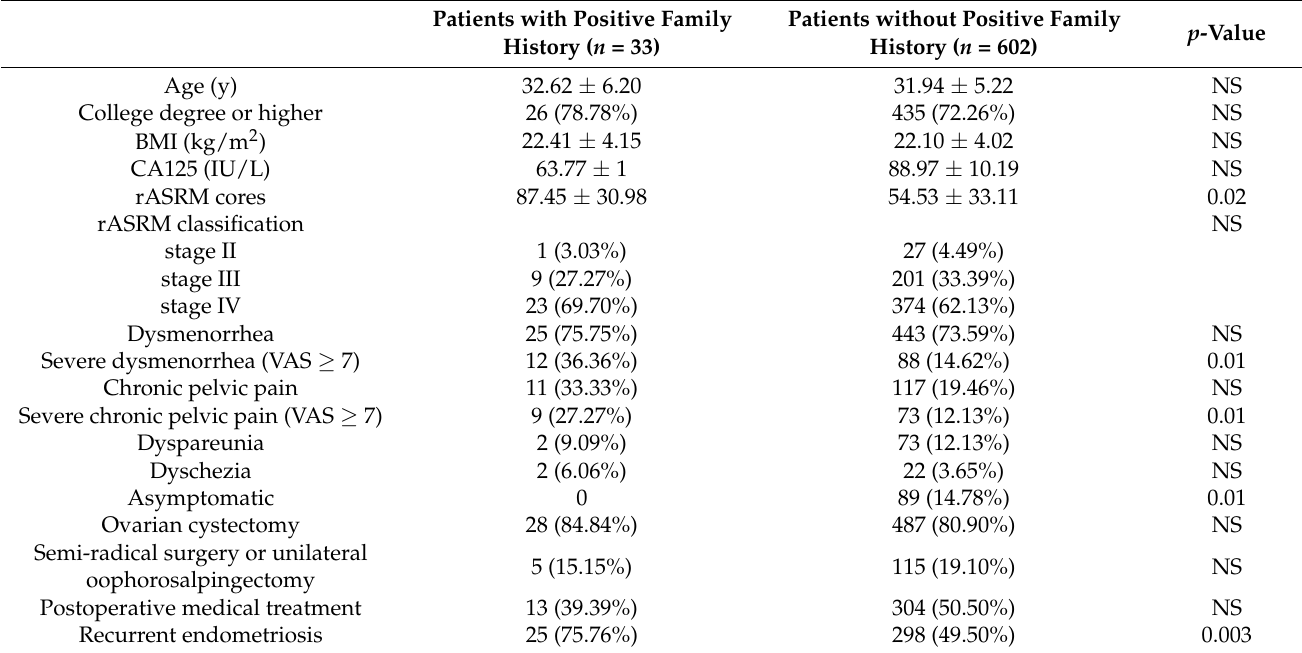
Table 2. Characteristics of patients with positive and negative family history.